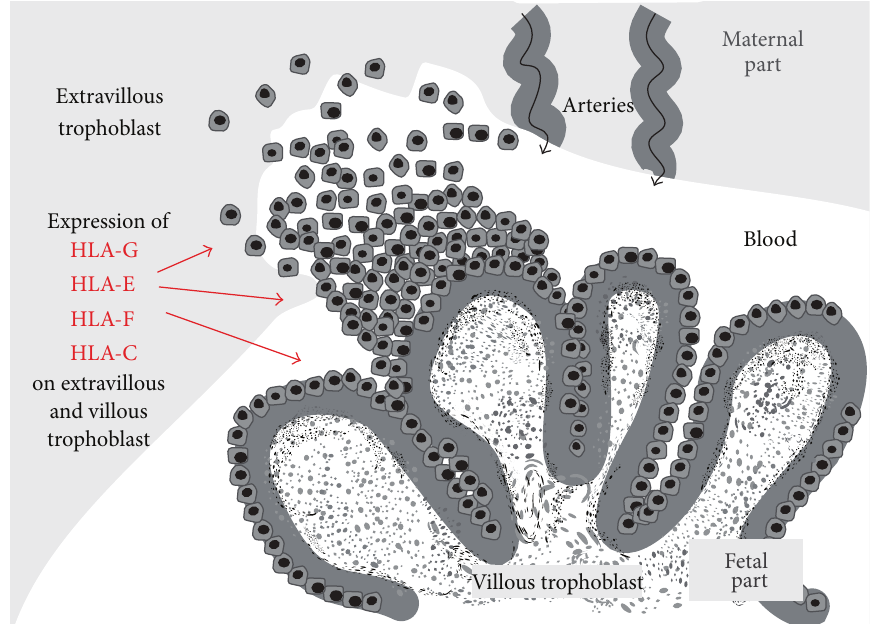
Figure 1: Expression of MHC I proteins (HLA) on the surface of the villous and extravillous trophoblast in humans. Only tolerance mediating HLA are